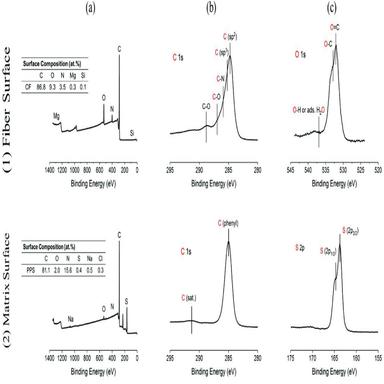
XPS Spectra of; (1) Fiber Surface: (a) Overall Spectra, (b) C1 s, (c) O1 s; and. (2) Matrix Surface: (a) Overall Spectra, (b) C1 s, (c) S2p.